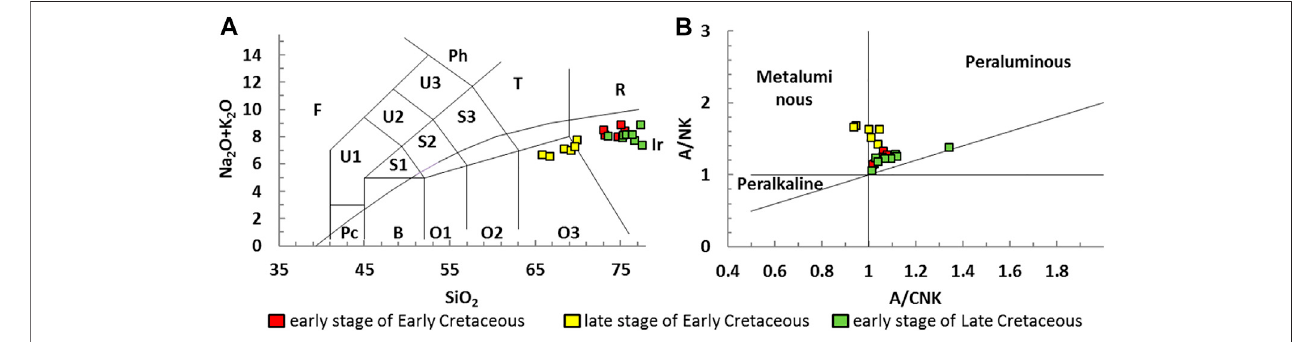
FIGURE 7 | TAS (A) and A/CNK (B) diagrams of magmatic rocks.